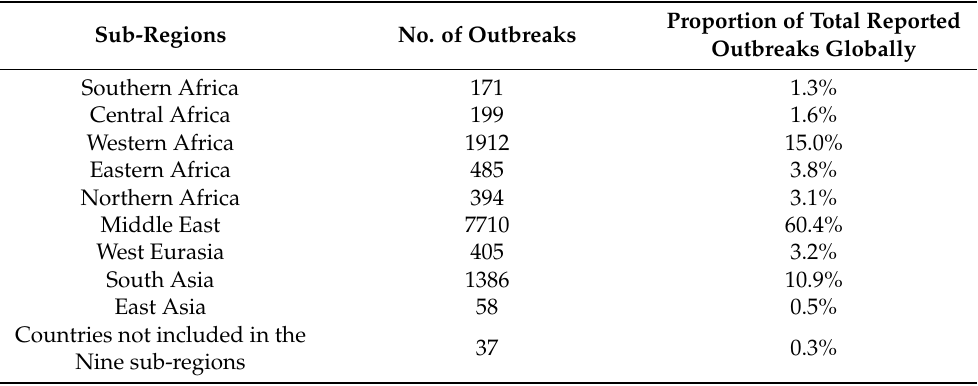
Figure 2. Global distribution of Peste des petits ruminants (PPR) burden showing the total number of reported PPR outbreaks from 2015 to 2019. Data are taken from the World Animal Health Information System (WAHIS). Table 2. Peste des petits ruminants (PPR) outbreaks reported to the World Organization for Animal Health (OIE) from 2015 to 2019 for nine different sub-regions.